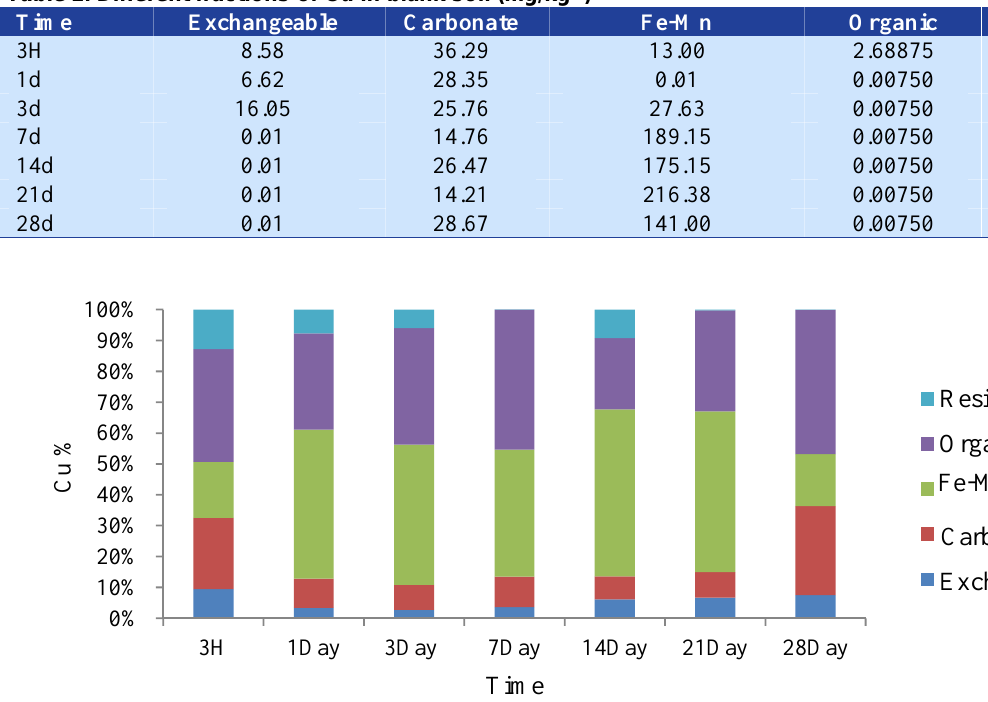
Figure 1. Different fractions of Cu in blank soil (%) Table 2. Different fractions of Cu in blank soil (mg/kg -1 )